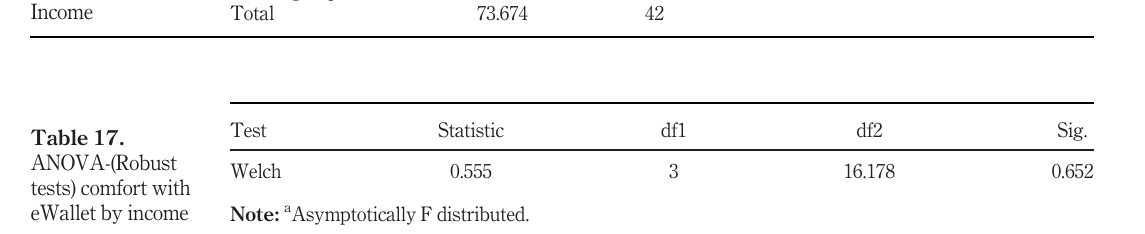
Table 16. ANOVA-Comfort with eWallet by Income